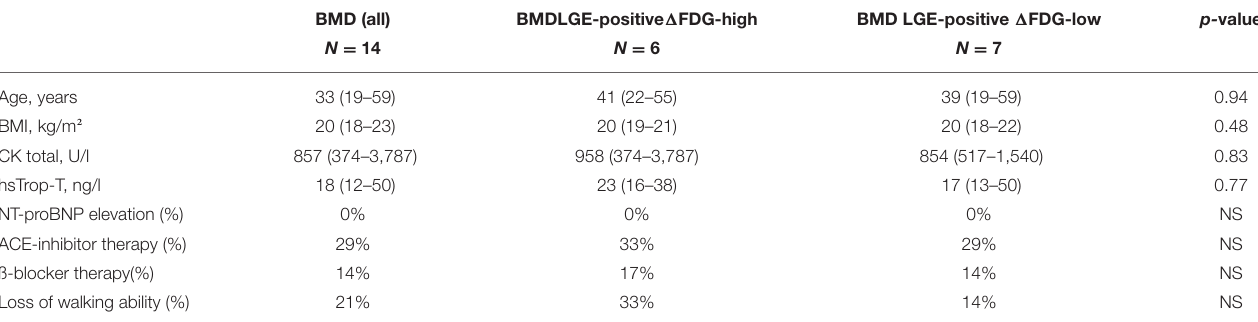
TABLE 1 | Patient characteristics.